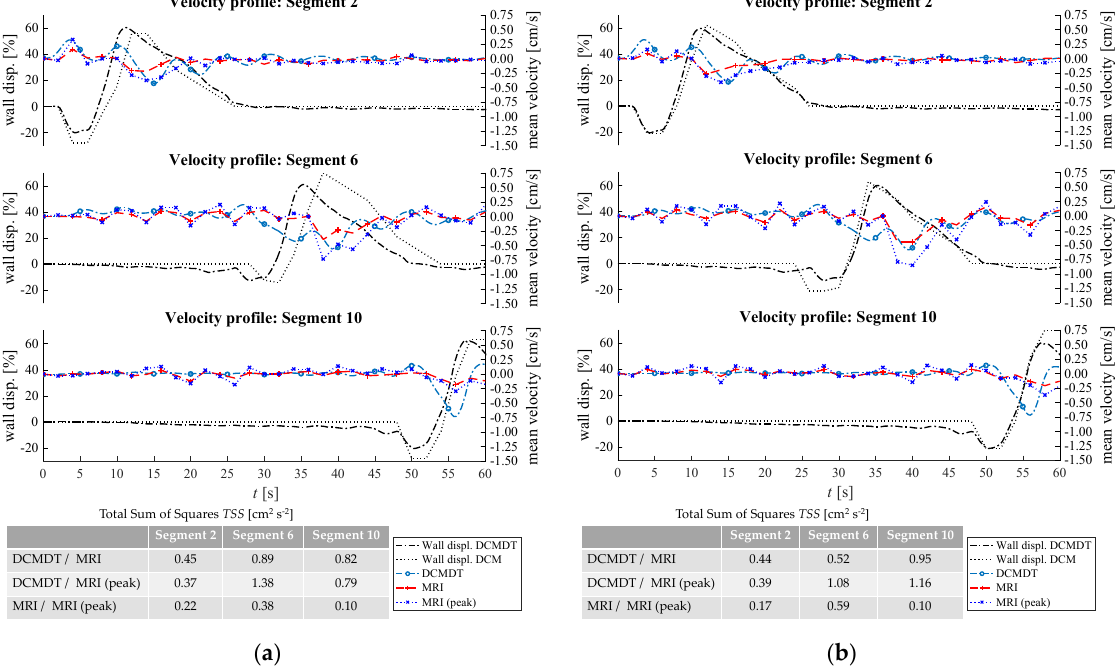
Figure 8. Comparison of the maximum fluid velocities and wall displacement profiles of the DCM and the DCMDT at low fluid volume, low fluid viscosity, and slow propagating PPW conditions are compared. The peak velocities fluctuated in a wavelike pattern similar to the mean velocities. Despite the similarities between the DCM and the DCMDT upon visual analysis, TSS val- ues were relatively high. This was due to the slight phase offset between the wavelike flow pattern of the DCM and the DCMDT which arose from marginally different initiation times. Next, the fill volume of the lumen was increased to 80% (Figure 9).